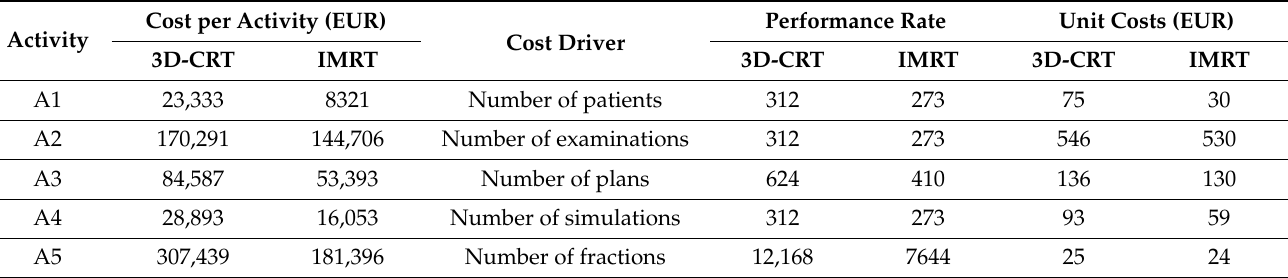
Table 11. Cost accounting per unit of activity.